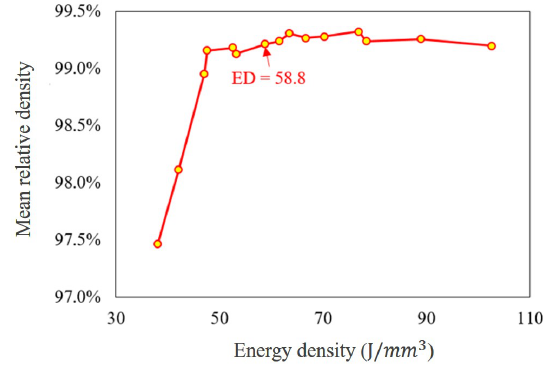
Figure 1. Relative density of the samples printed with the combination of all